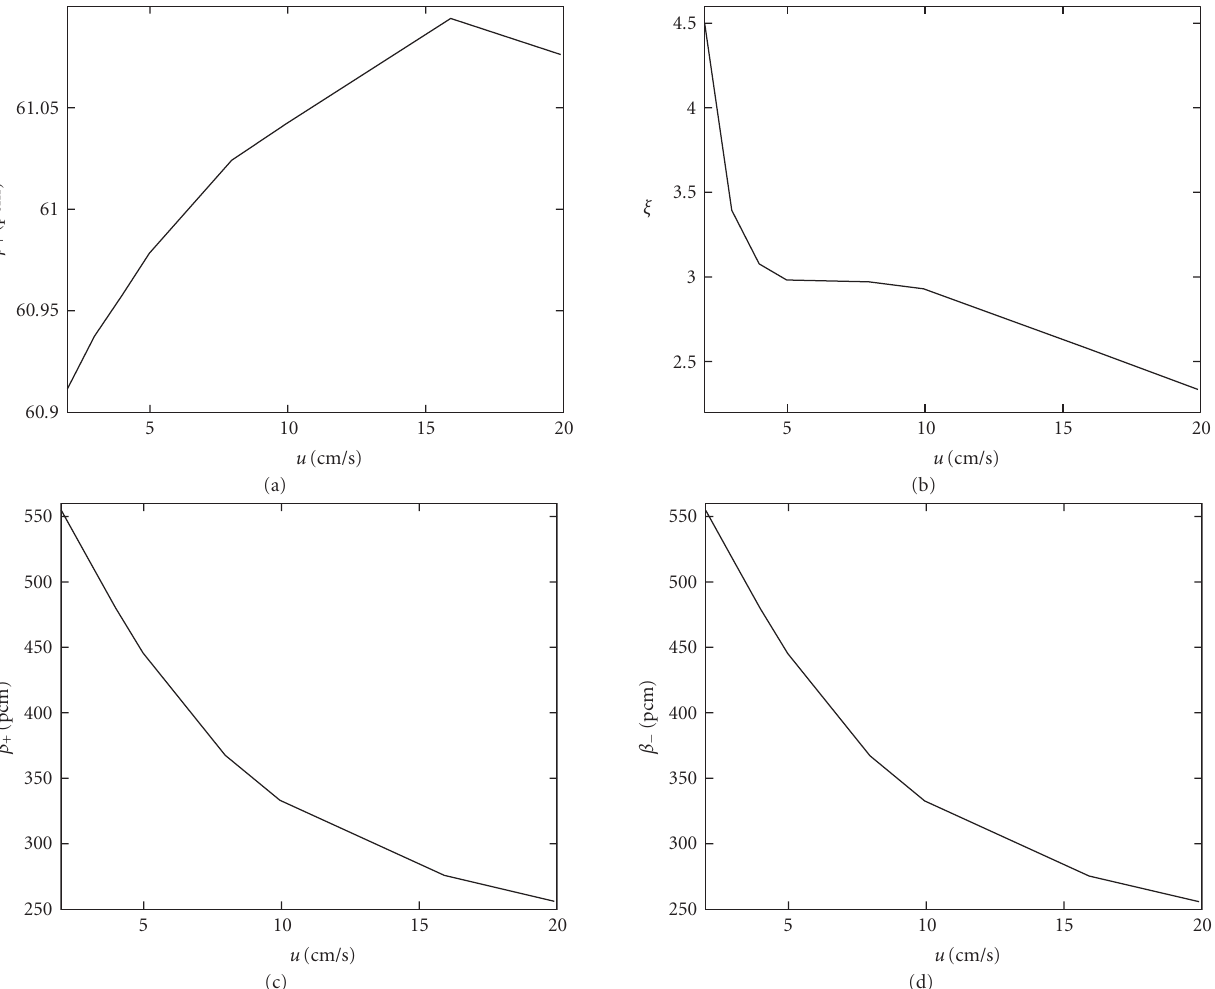
Figure 5: Parametric study of the e ff ect of the fuel velocity u on the integral parameters regulating the divergence of the power. Top left: mean reactivity inserted in the interval τ c ; top right: value of the fundamental eigenvalue ξ ; bottom left: mean value of (cid:6) β during τ c ; bottom right: value of (cid:6) β during τ l .